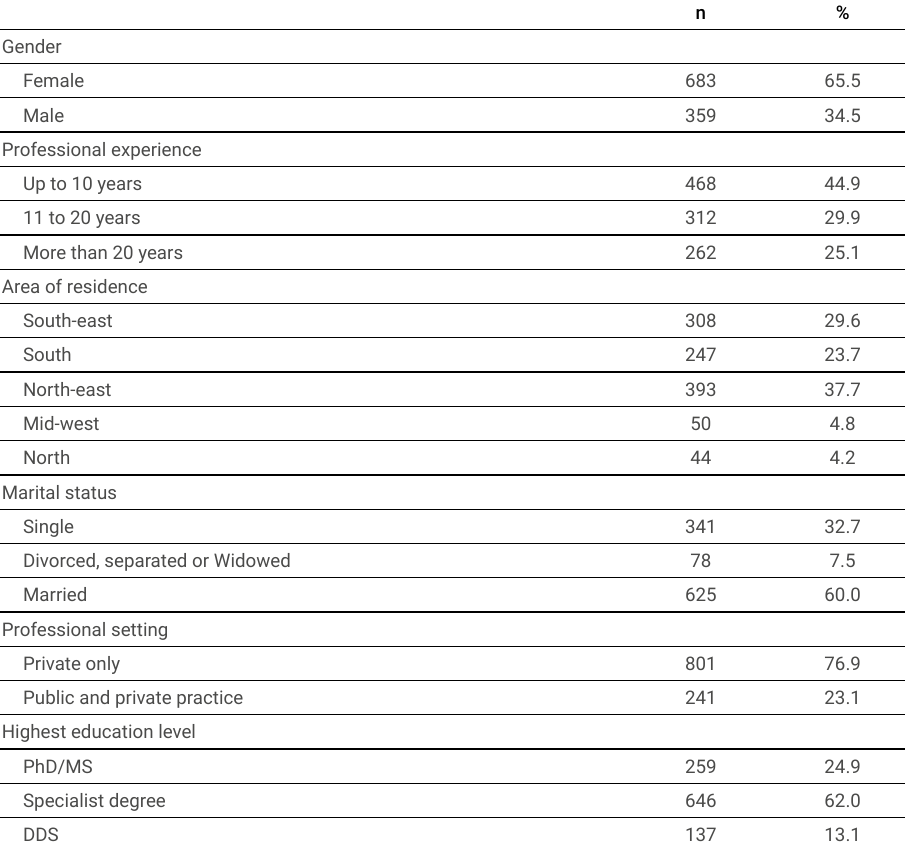
Table 1. Percent distribution of respondents by background characteristics